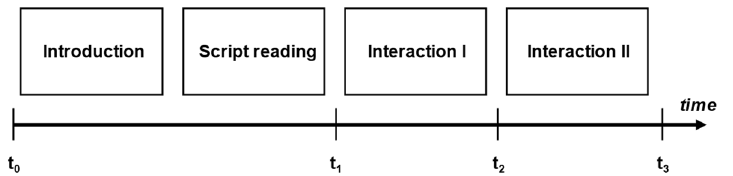
Figure 11. Scheme of the experiment. At first between time t 0 and t 1 the users were debriefed on the experiment and tested a sample task with the glove by also providing initial feedback on the interface. Afterwards, the experiment started at t 1 with the first interaction and ended at t 2 where the users provided feedback about the interaction. Finally, the second interaction unfolded between t 2 and t 3 and concluded with the users providing their feeling about the second interaction at t 3